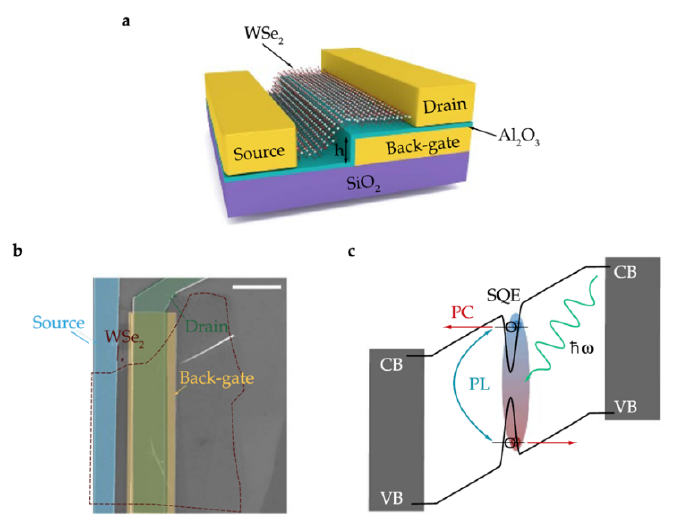
Figure 15. ( a ) Schematic sketch of the device structure with monolayer WSe2 over a step (height h = 105 nm). The WSe2 flake is contacted by Ti/Au (5/200 nm) electrodes and separated from the back-gate electrode by a 20 nm thick gate dielectric (Al2O3). ( b ) False-color scanning electron image of the device (Scale bar, 5 µ m). ( c ) Schematic band diagram of a SQE photodiode for negative drain-source voltage (V DS). Following resonant optical excitation, single electron-hole pairs are generated and dissociated at the junction, which results in a PC [71].